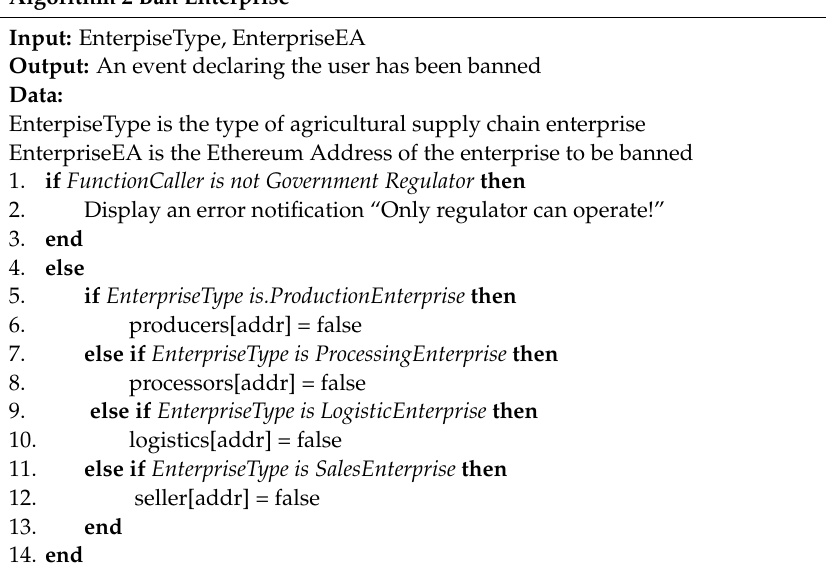
Algorithm 2 Ban Enterprise